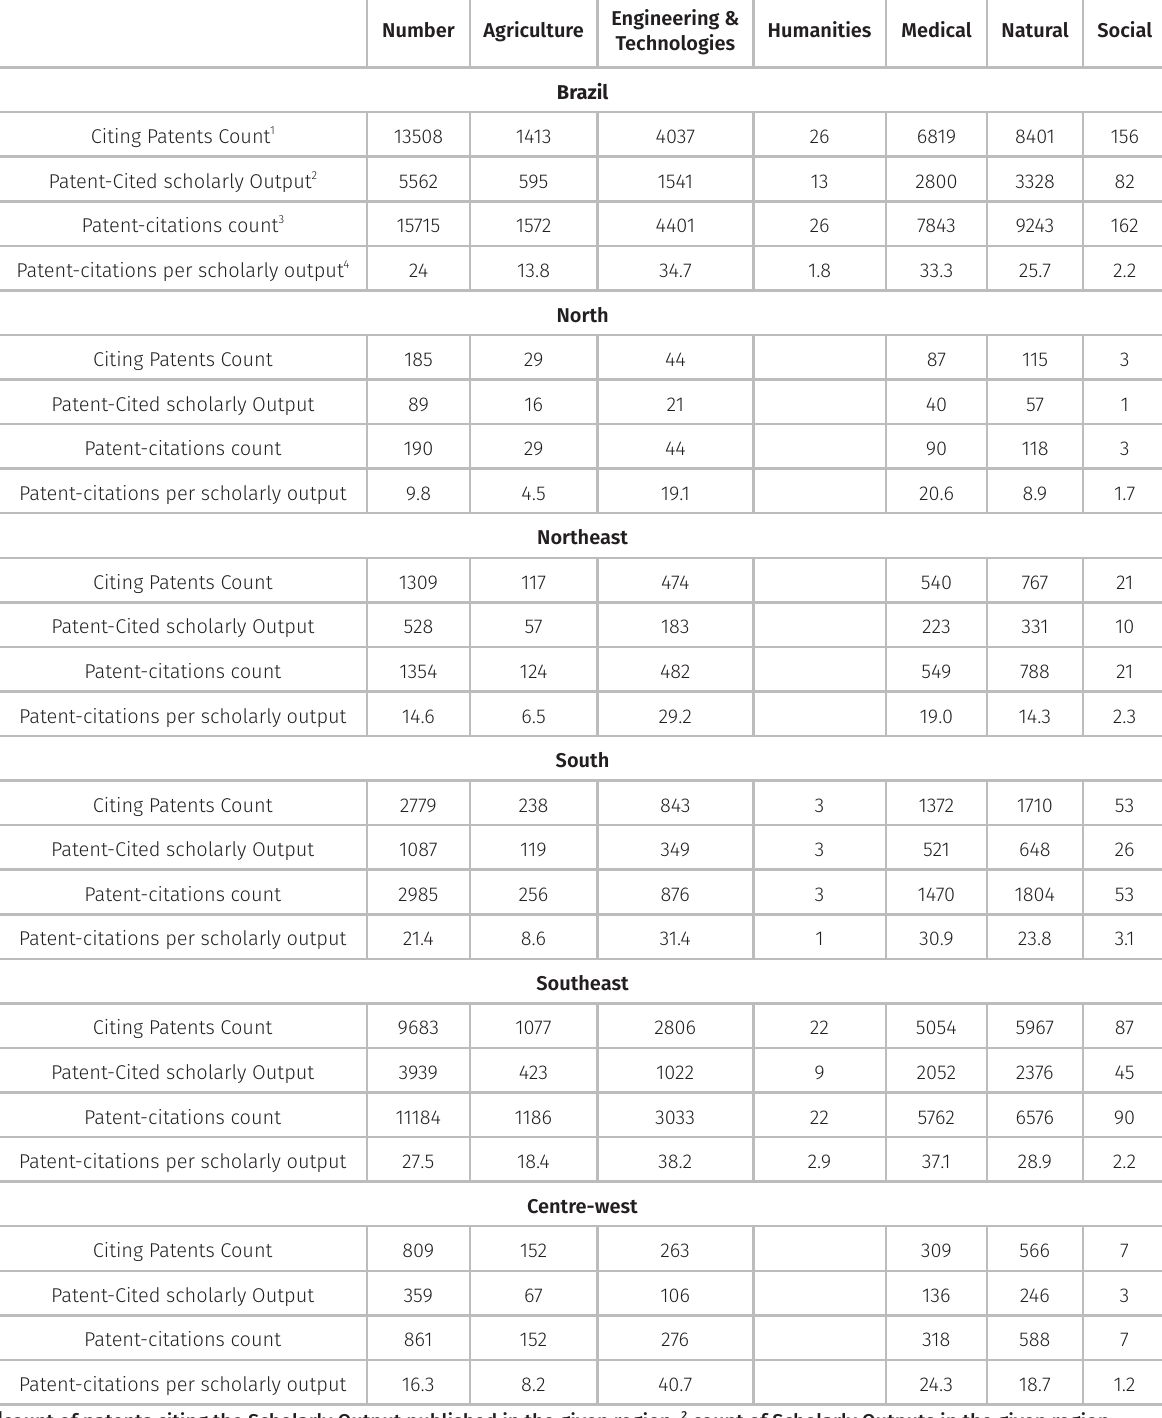
Table VI. Economic impact of Brazilian Universities and Research Institutions (SciVal ®) from all patent offices worldwide